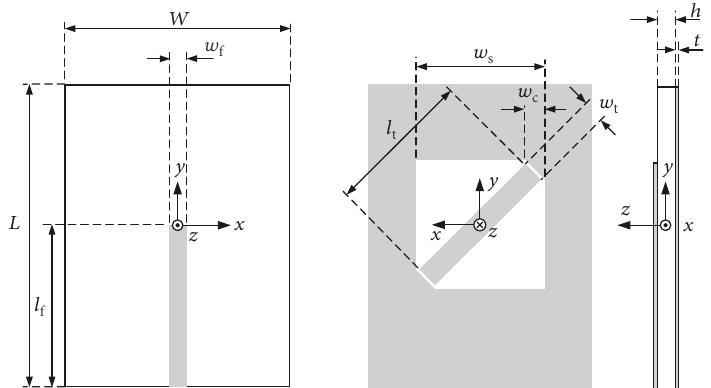
Figure 3: Structure of the truncated square patch antenna with slant strip (front view, rear view, and side